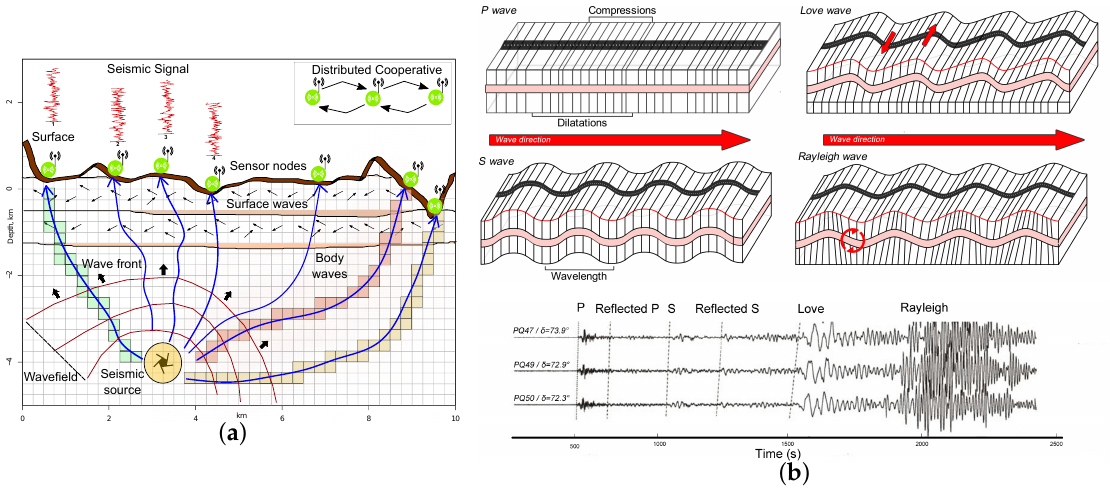
Figure 2. Illustration of seismic imaging. ( a ) Concept. ( b ) Body waves (P and S) and surface waves (Love and